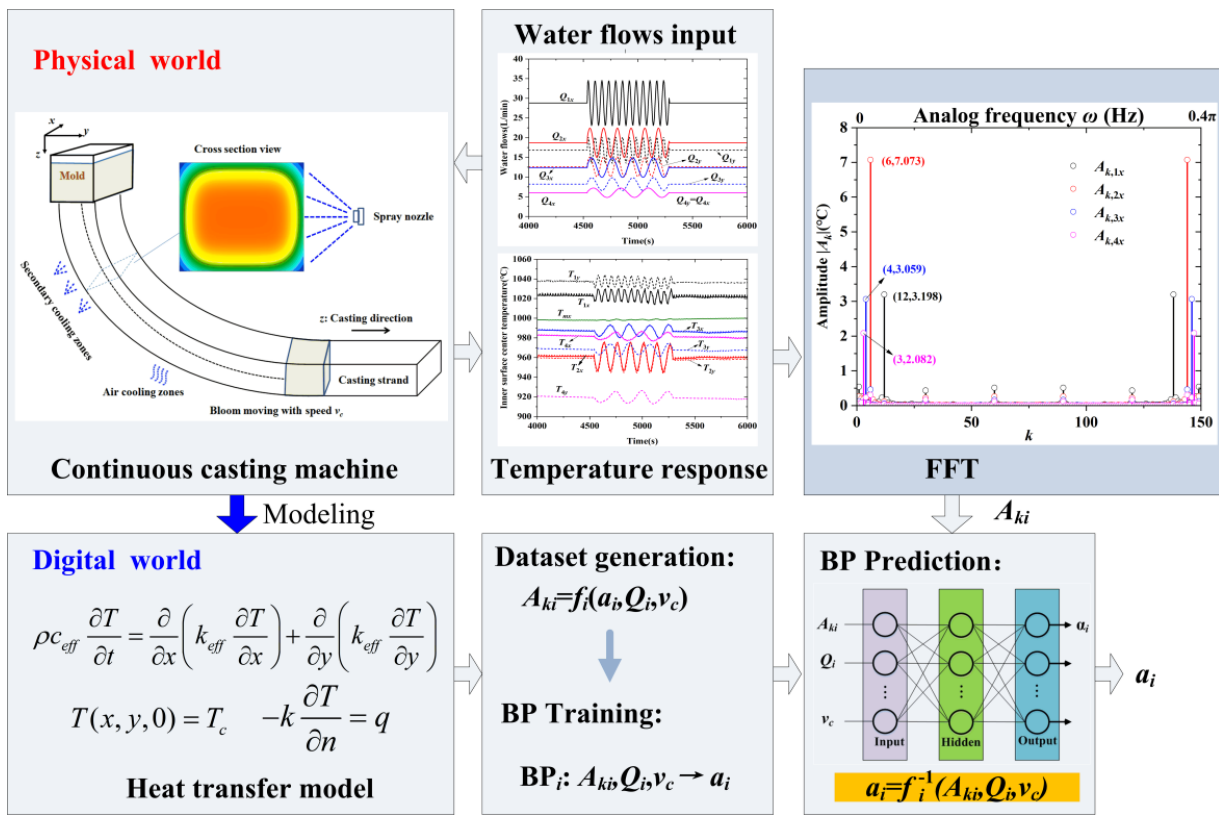
Figure 3. Online calibration method.